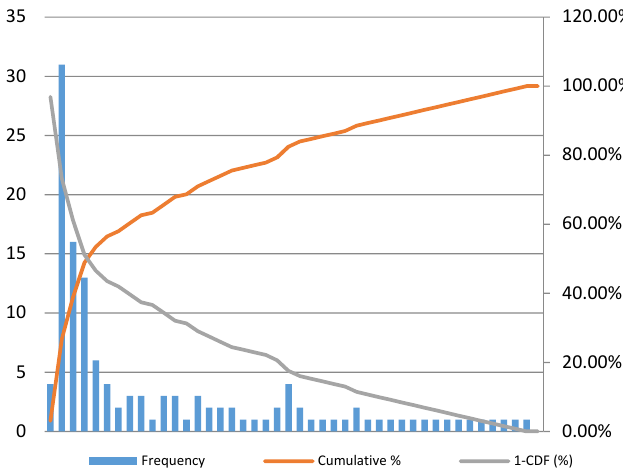
Figure 8. Histogram, cumulative distribution and complement of cumulative distribution of V int .